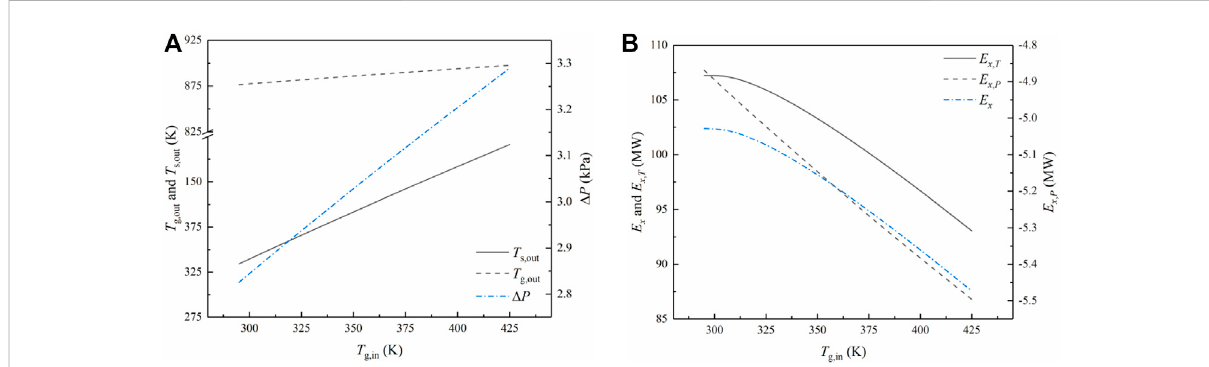
FIGURE 11 In fl uences of the gas inlet temperature T g , in on the vertical cooling process: (A) Change of the sinter outlet temperature T s , out , gas outlet temperature T g , out and pressure drop Δ P with T g , in ; (B) Change of the temperature exergy E x , T , pressure exergy E x , P and income exergy E x with T g , in